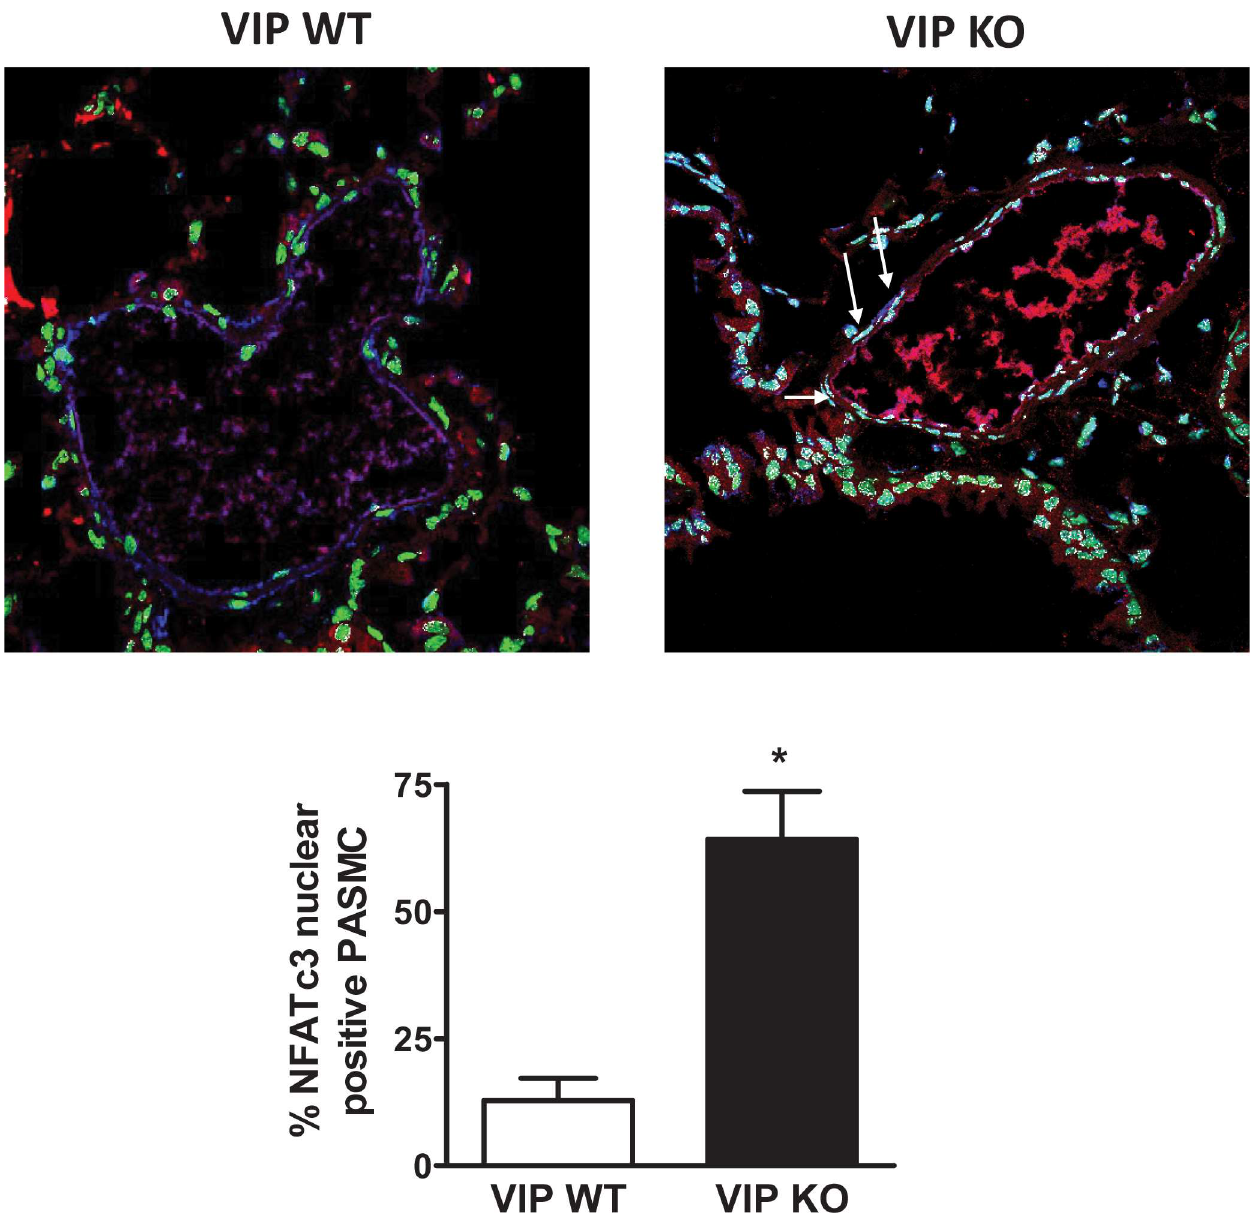
Fig 2. PASMC NFATc3 nuclear accumulation is enhanced in VIP KO mice. Top: representative immunofluorescenceconfocalmicroscopy images. Nuclei depictedin green (SYTOX), NFATc3 in red and α -actin in blue. NFATc3 nuclear co-localization in white (see white arrows). Bottom: summary of percent of PASMC with NFATc3 in the nucleus.n = 15 to 28 arteries from 6 mice each group. * p < 0.001